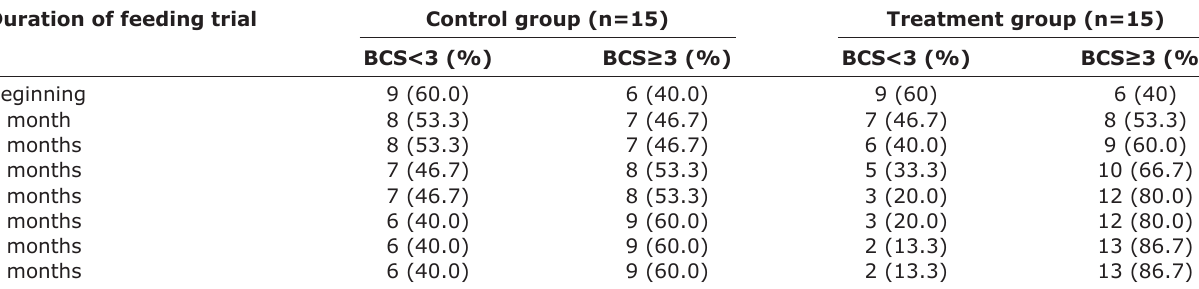
Table-6: The measurement of body condition score in control and treatment groups throughout feeding trial. Duration of feeding